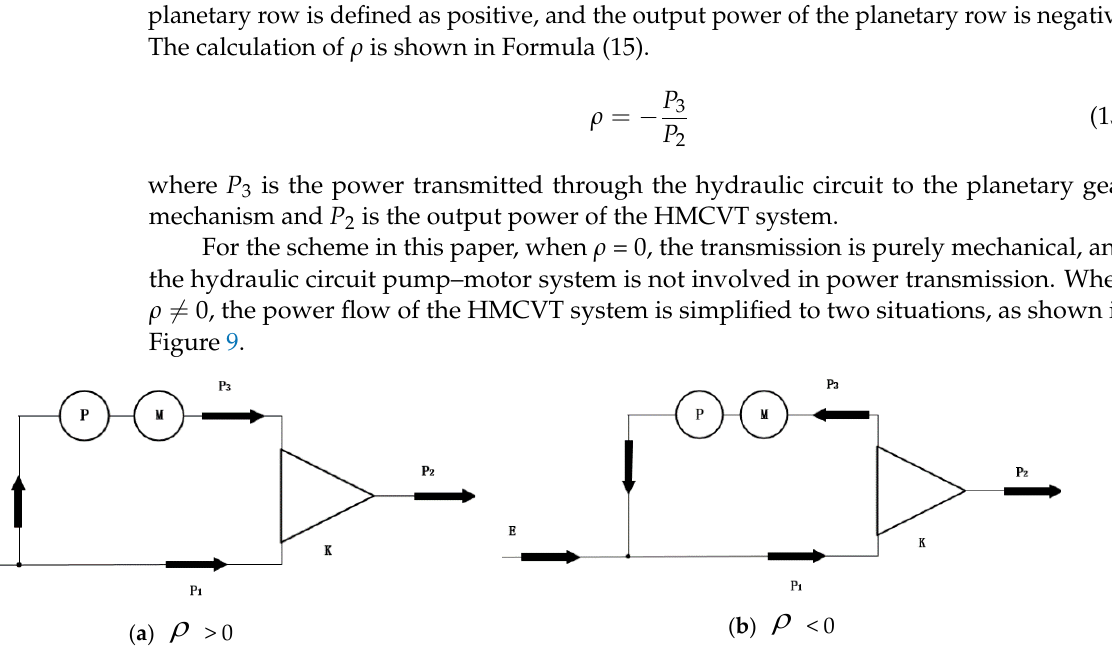
Figure 9. HMCVT power split diagram.